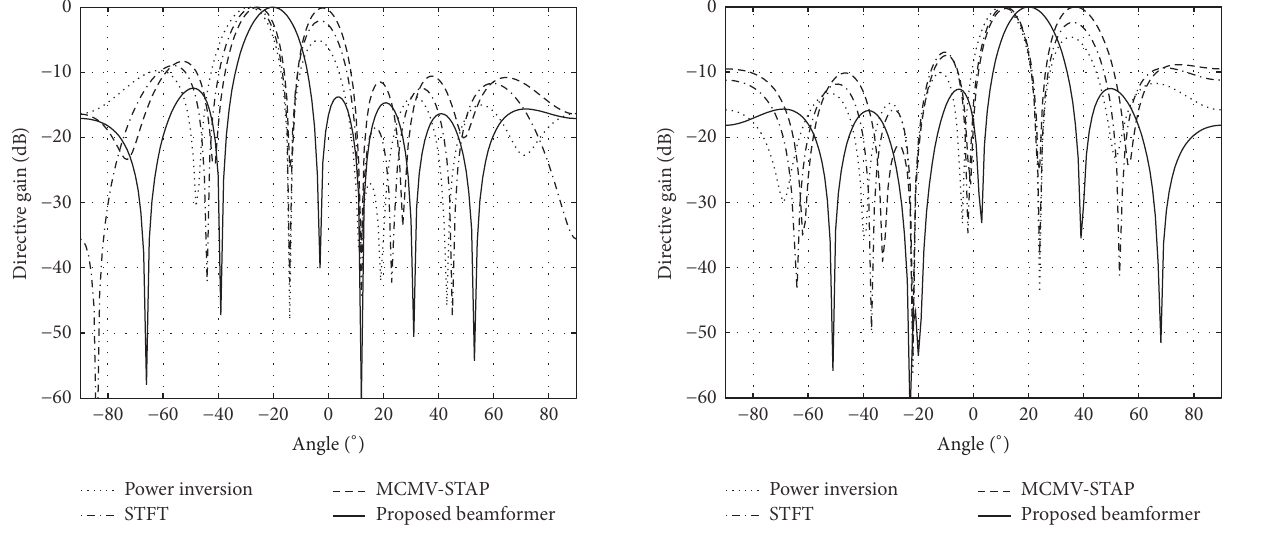
Table 1: incidence signal of navigation signal is − 20 degrees and ones of jamming signals are − 14 degrees and 12 degrees.